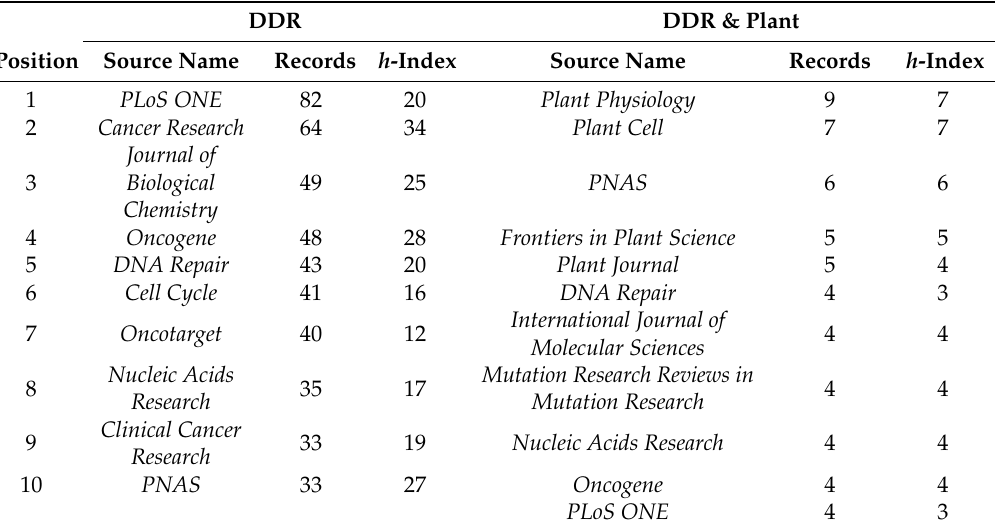
Table 2. Distribution of publications by